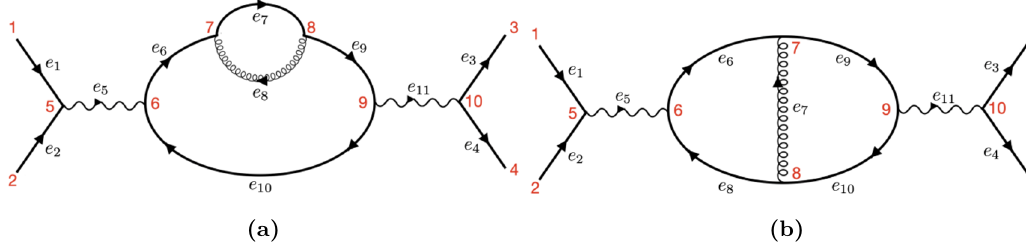
Figure 1. The two supergraphs Self-Energy (SE, 1a) and Double-Triangle (DT, 1b) contributing to the NLO QCD correction to the cross-section of the process e + e − → γ ? → d ¯ d